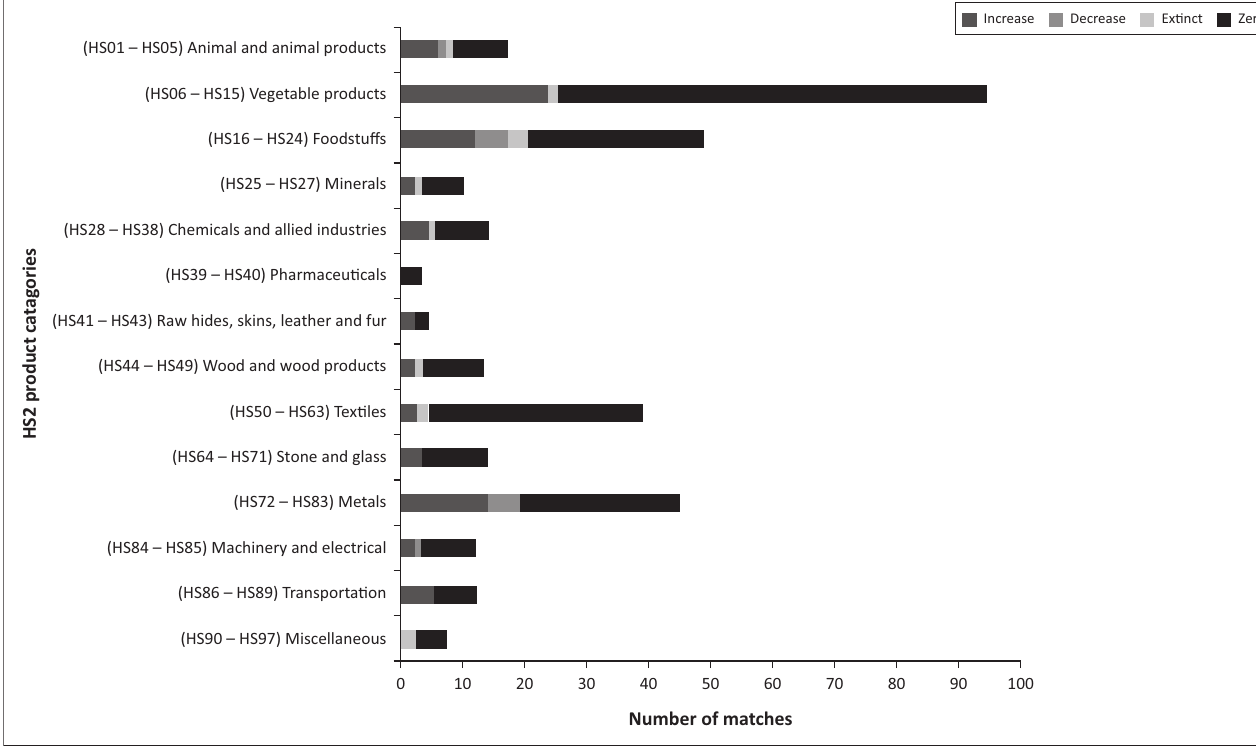
FIGURE 2: Tripartite Free Trade Agreement intra-regional trade opportunities: Product category analysis. TABLE 5: Top 20 importer–product–exporter matches with an increase in trade: 2010–2014. Importer Product code Product (HS6 digit-level)